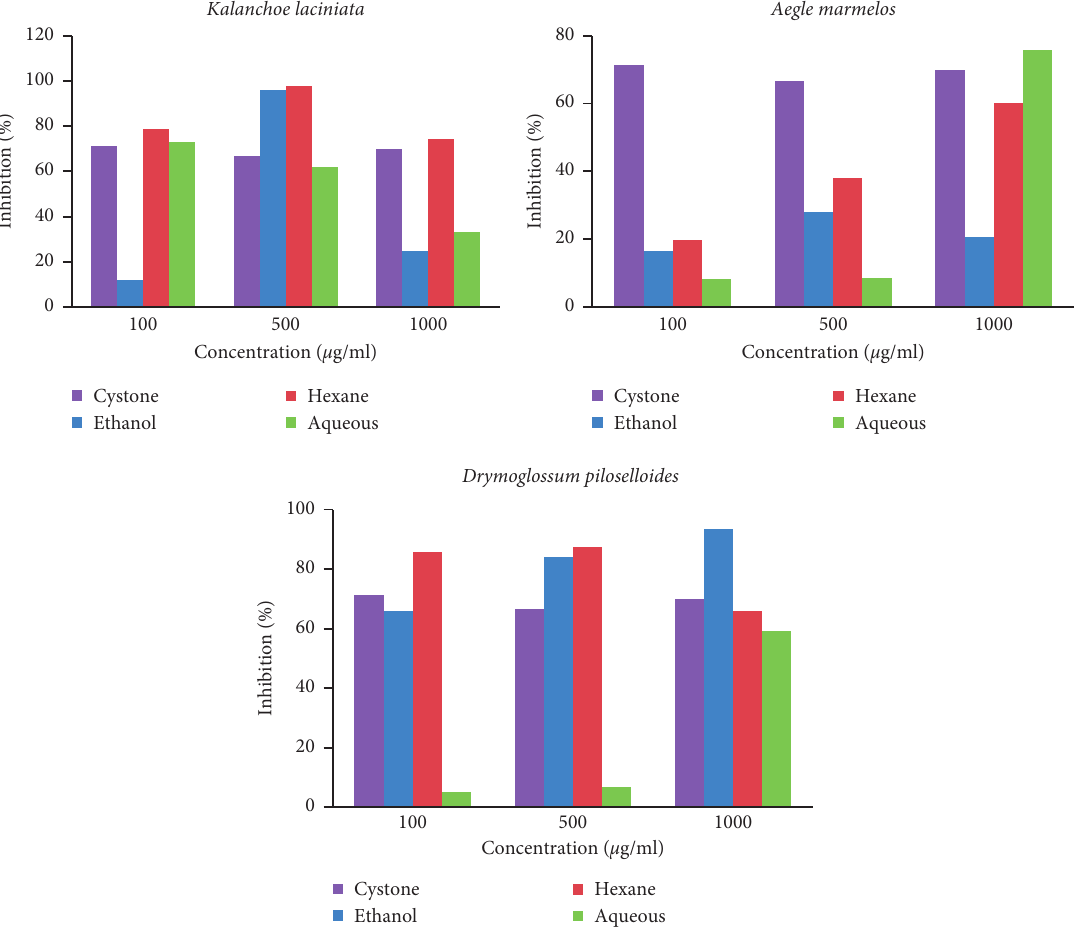
Figure 4: Percentage of inhibition of different extracts of plants on calcium oxalate crystal grow. Each graph shows the dose response effect of each plant extracted in ethanol, hexane, and water against the standard drug, Cystone. At any concentration of the plant extract tested, a significant difference ( p < 0.05) in inhibition was observed between the plant extract treated tubes and the positive control,